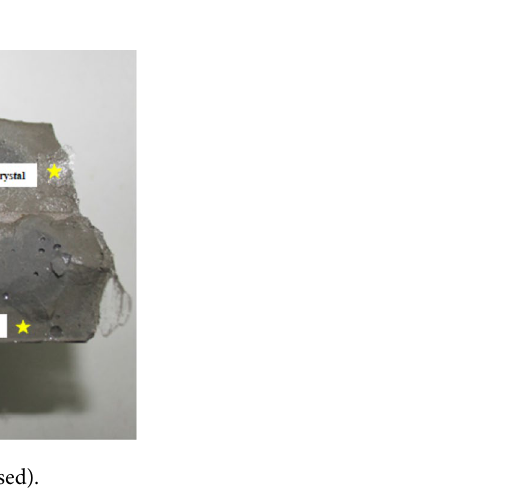
Figure 6. Prefabricated crack surface after test (color should be used).